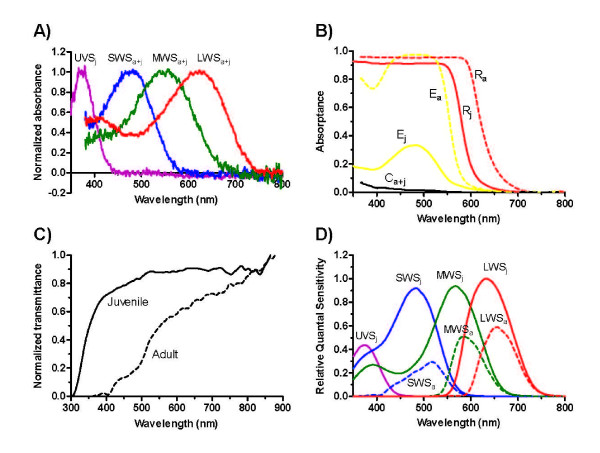
Spectral characteristics of retinal photoreceptors and ocular media in juvenile and adult Australian lungfish (Neoceratodus forsteri). (A) Normalized absorbance spectra of cone photoreceptor visual pigments. UVS, SWS, MWS and LWS refer to the pigments found in the ultraviolet-, short-, medium- and long-wavelength-sensitive cones, which have wavelengths of maximum absorbance (λmax) at 366, 479, 558 and 623 nm, respectively. The absorbance spectrum of the rod pigment (λmax 540 nm) is not shown. All pigments are found in juvenile lungfish (j), but the UVS cones are absent from adults (a). (B) Absorptance spectra of intracellular organelles and spectral filters. R, E and C refer to the red oil droplets, yellow ellipsoid pigment and colourless oil droplets in the LWS, MWS and SWS/UVS cones (spectra pooled), respectively. The absorptance spectrum of the yellow paraboloid pigment in the MWS cones of adult Neoceratodus (not shown) is almost identical to that of the ellipsoidal pigment in juveniles. (C) Normalized transmittance spectra of the combined ocular media (lens, cornea, etc.) of adult and juvenile lungfish. Note the increased absorption of shorter wavelength light by the ocular media of the adult. (D) Calculated quantal spectral sensitivities of the 4 cone types in juveniles and 3 cone types in adults, taking into account the spectral filtering effects of the intracellular spectral filters and ocular media on the absorption of light by the visual pigment in each cone type